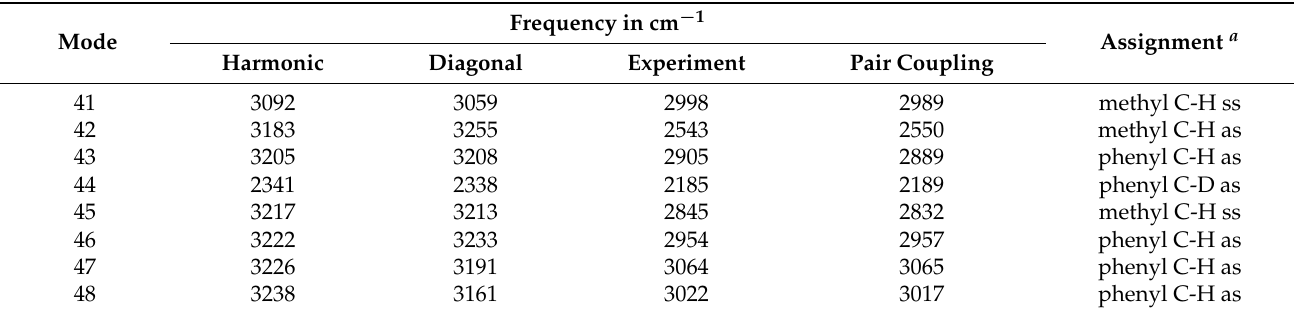
Table 1. The harmonic and anharmonic C-H stretch vibrational frequencies are calculated using different level of computa- tional methods and their assignment for deuterated MB. one-dimensional potential energy surfaces are calculated with the DF-MP2/aug-cc-pVTZ and pair coupling potential surfaces are calculated with DF-MP2/cc-pVDZ. Mode numbers are based on normal mode